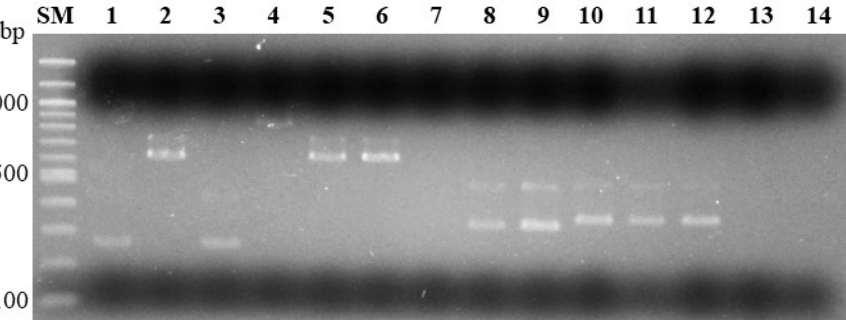
Figure 2. Multiplex PCR for species identification and trichothecene typing of the Fusarium graminearum species complex. Multiplex PCR with the primers 3CON, 3D3A, 3D15A, and 3NA for trichothecene typing. Expected amplicon sizes were 3-acetyl deoxynivalenol (3ADON): 243 bp; 15-acetyl deoxynivalenol (15ADON): 610 bp; and nivalenol (NIV): 840 bp. Multiplex PCR with primers